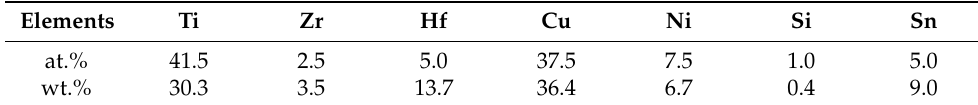
Table 1. Chemical compositions of the Ti-based BMG powder. Elements Ti Zr Hf Cu Ni Si Sn